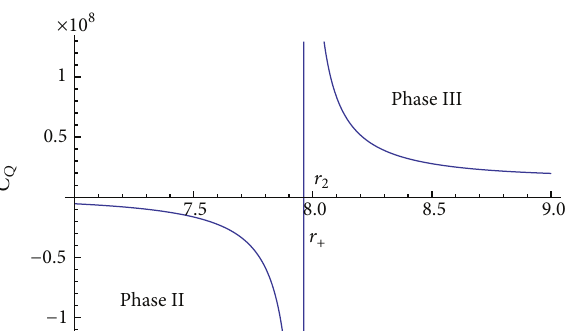
Figure 3: Plot of specific heat ( 𝐶 𝑄 ) against horizon radius ( 𝑟 + ), for 𝛼 󸀠 = 0.5 , 𝑄 = 15 , and 𝑏 = 0.60 at the critical point 𝑟